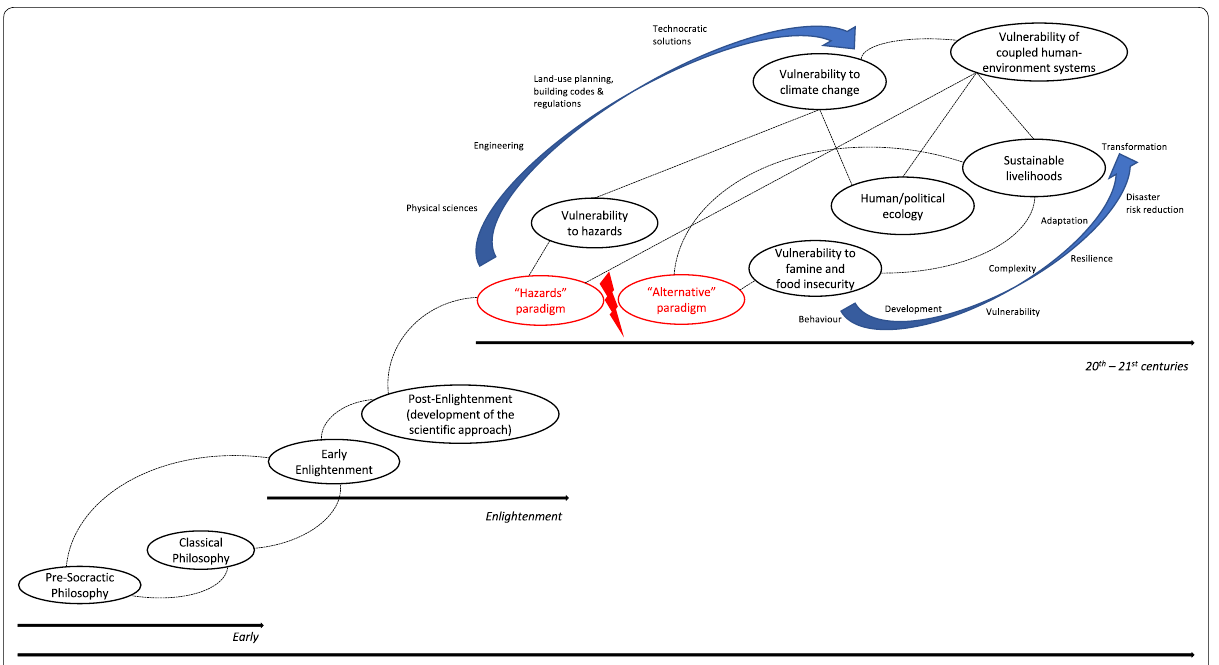
Fig. 3 Evolution of philosophical paradigms, concepts and approaches to the study of hazards and disasters. These might loosely be thought of as occurring in three stages: early, the enlightenment and the 20th and 21st